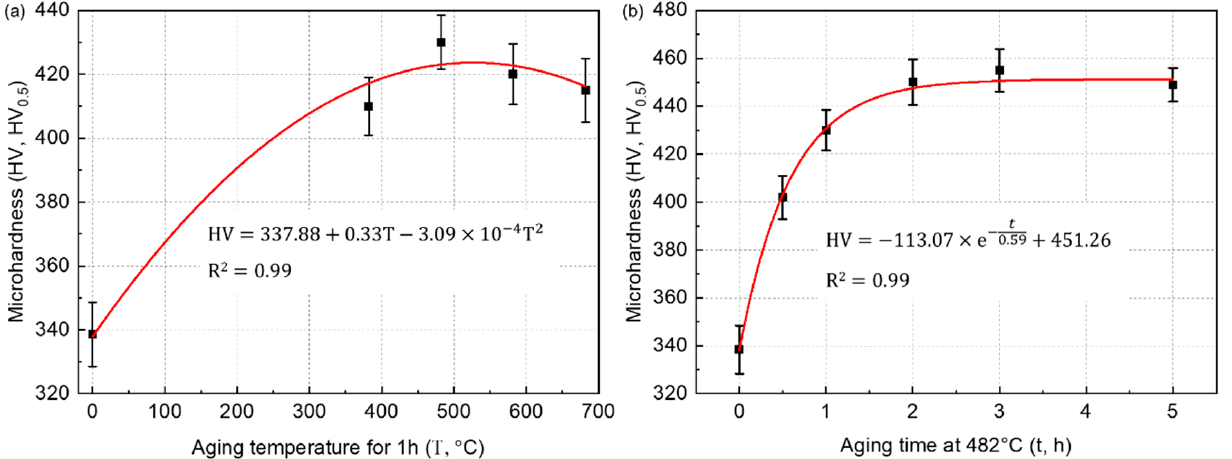
Figure 8. Microhardness variation of the SLM-manufactured 17-4 PH steel samples after aging treatments under di ff erent ( a ) temperatures and ( b ) holding times.